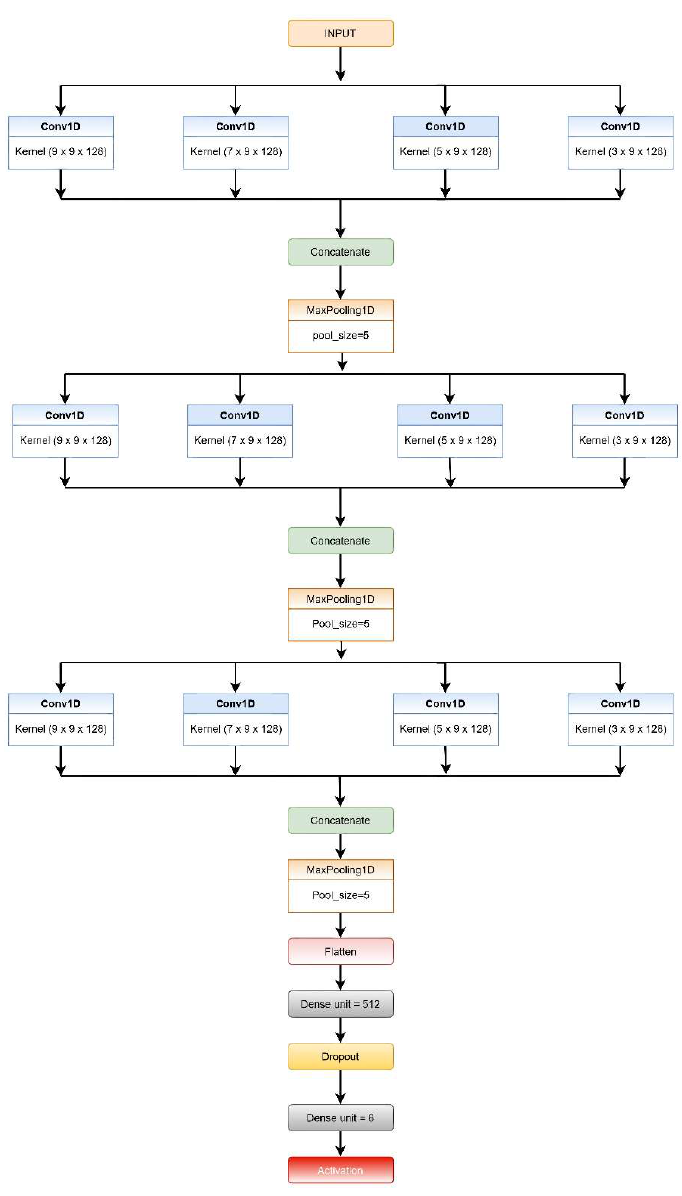
Figure 2. Schematic diagram of the CNN-net